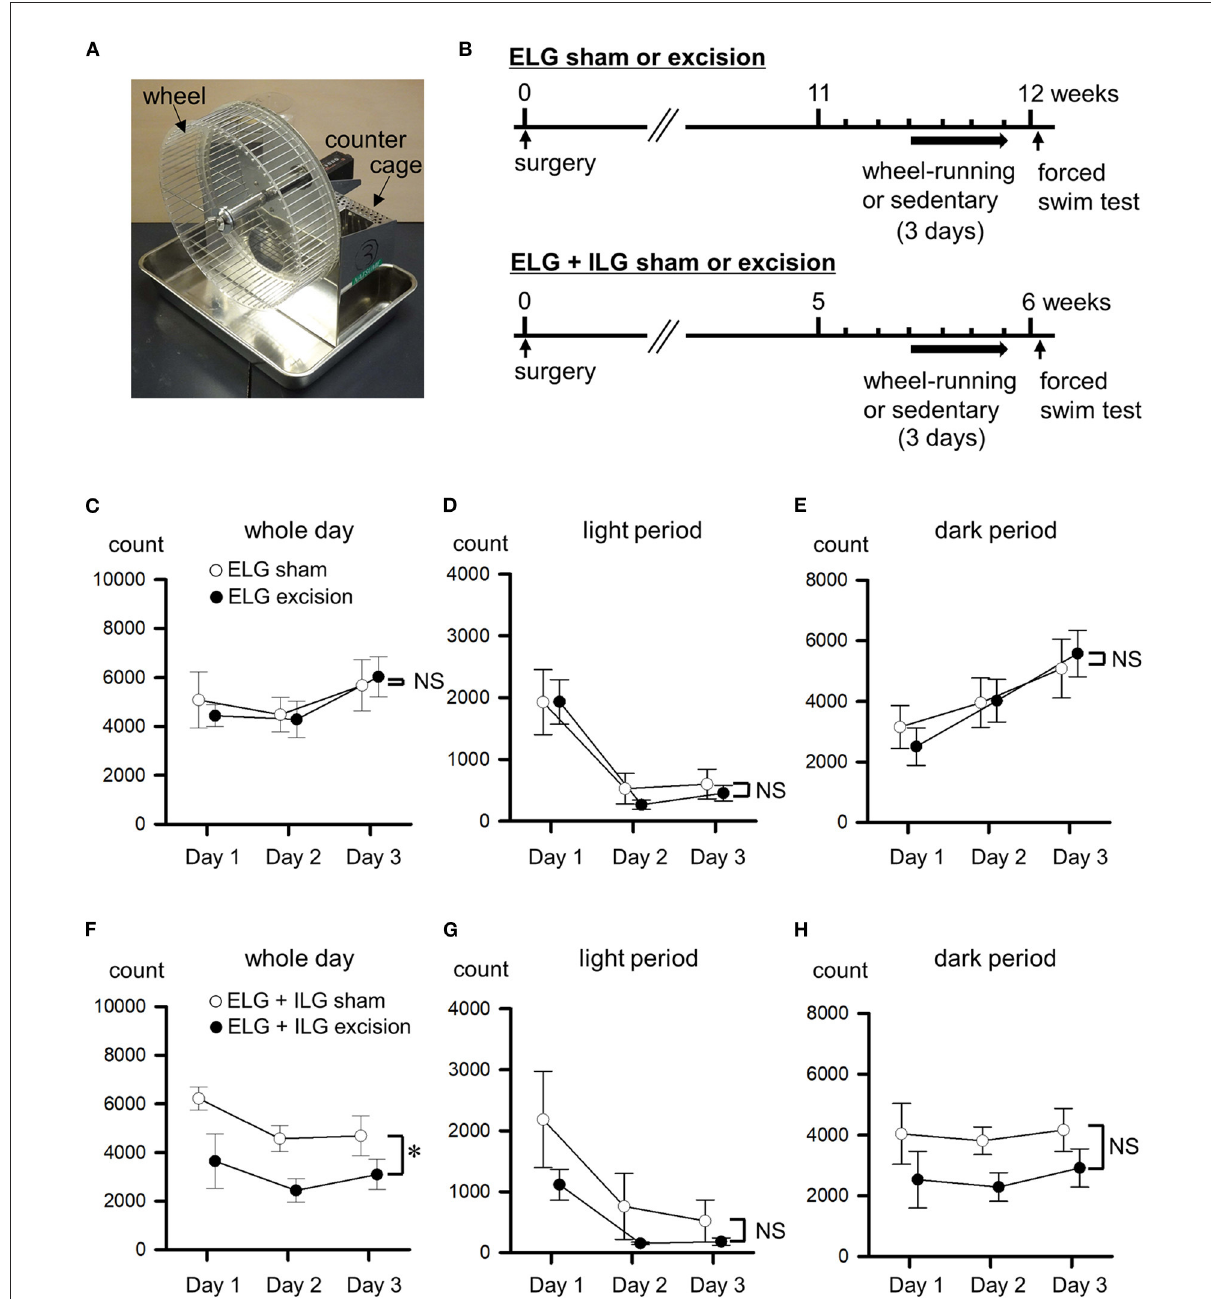
FIGURE4 Effects of lacrimal gland excisions on wheel-running activity. (A) Running wheel apparatus. (B) Timelines of the experimental procedure. (C–H) The wheel-running activities from the first to third day are shown as counts of wheel rotation in a whole day (C,F) divided into the light period (D,G) and dark period (E,H) . Sham-operated mice (open circles), ELG excision mice [closed circles in (C–E) ], and ELG + ILG excision mice [closed circles in (F–H) ]. Each point and the corresponding vertical bar represent the mean ± SEM ( n = 8). * P < 0.05 vs . the sham-operated